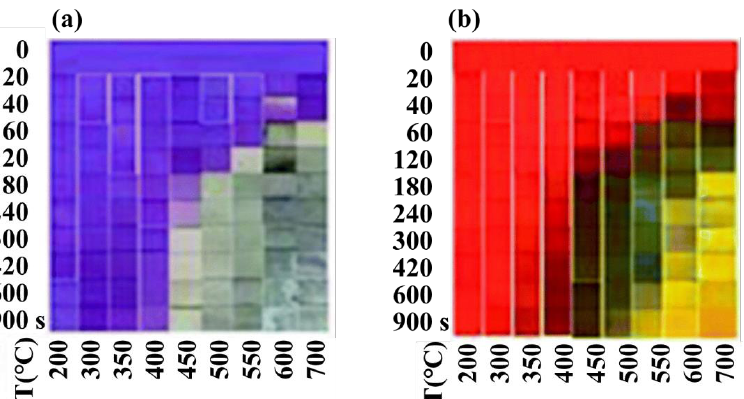
Figure 13. Standard color changes observed at different temperatures from ( a ) a single-change-type paint and ( b ) a multi-change-type paint [117]. Reprinted with permission from [117]. Springer Na- ture, 2019.